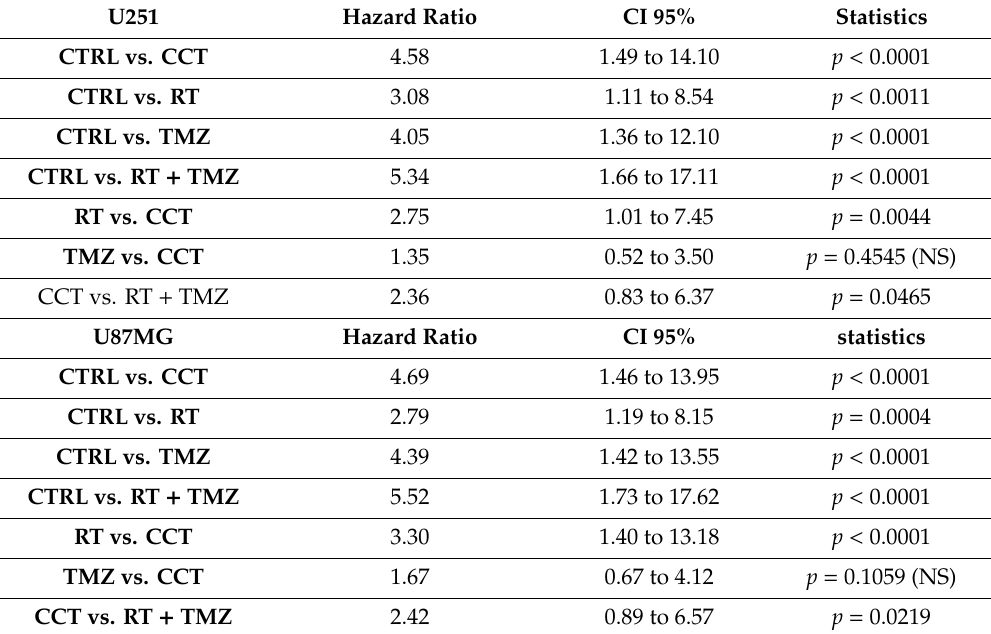
Table 3. Summarized statistical data from Kaplan Meier curves of Figure